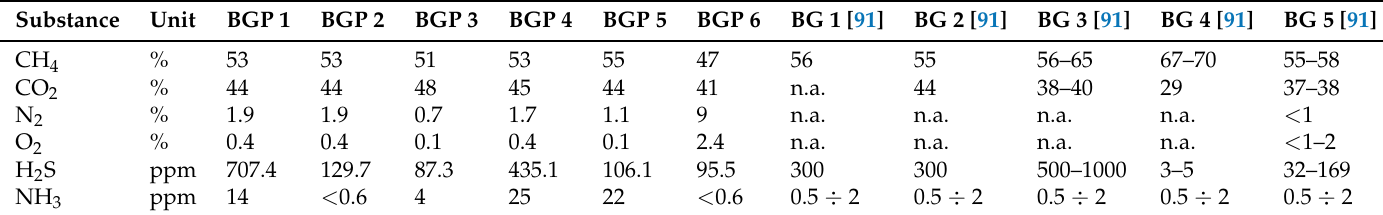
Table 14. Biogas composition comparisons with data available in the literature.